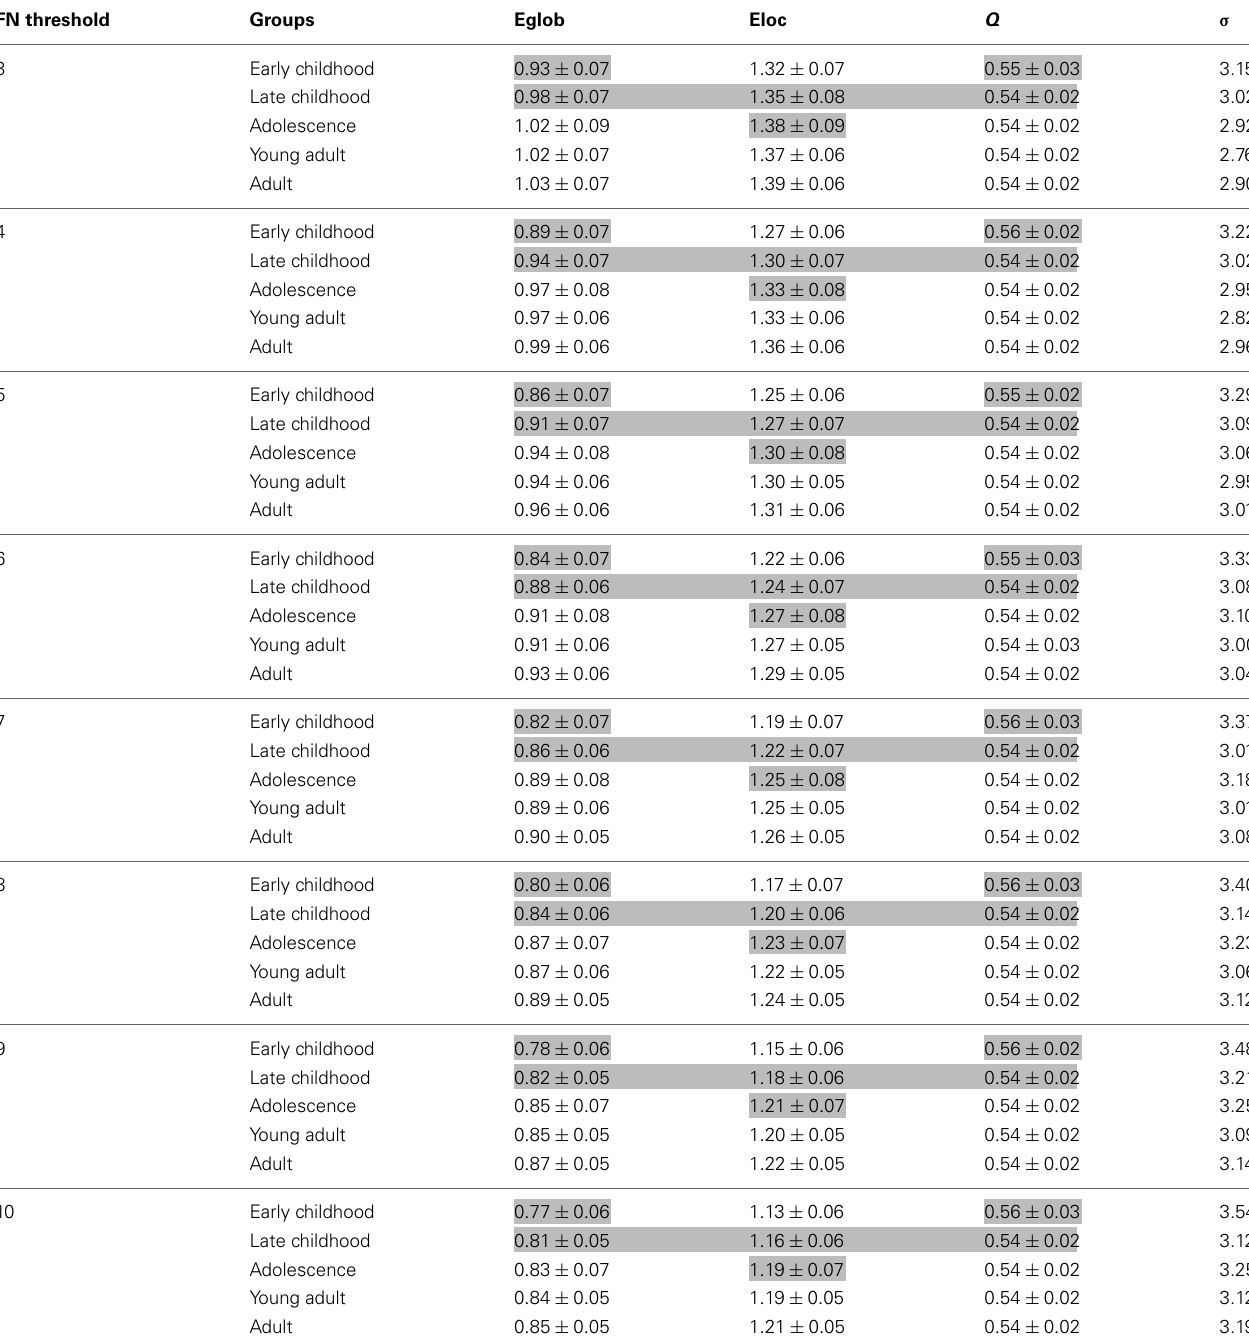
Adjacent groups show significant differences or trend in network properties are highlighted in shaded cells. FN: fiber number, Eglob: global efficiency, Eloc: local efficiency, Q: modularity, σ : small